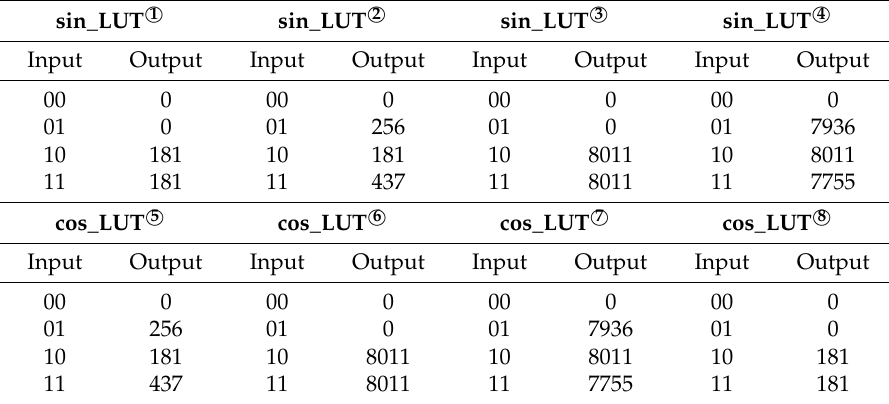
Figure 11. Implementation of the digital lock-in algorithm in the field-programmable gate array (FPGA) and microcontroller unit (MCU). Table 3. The results of LUT about the different reference.